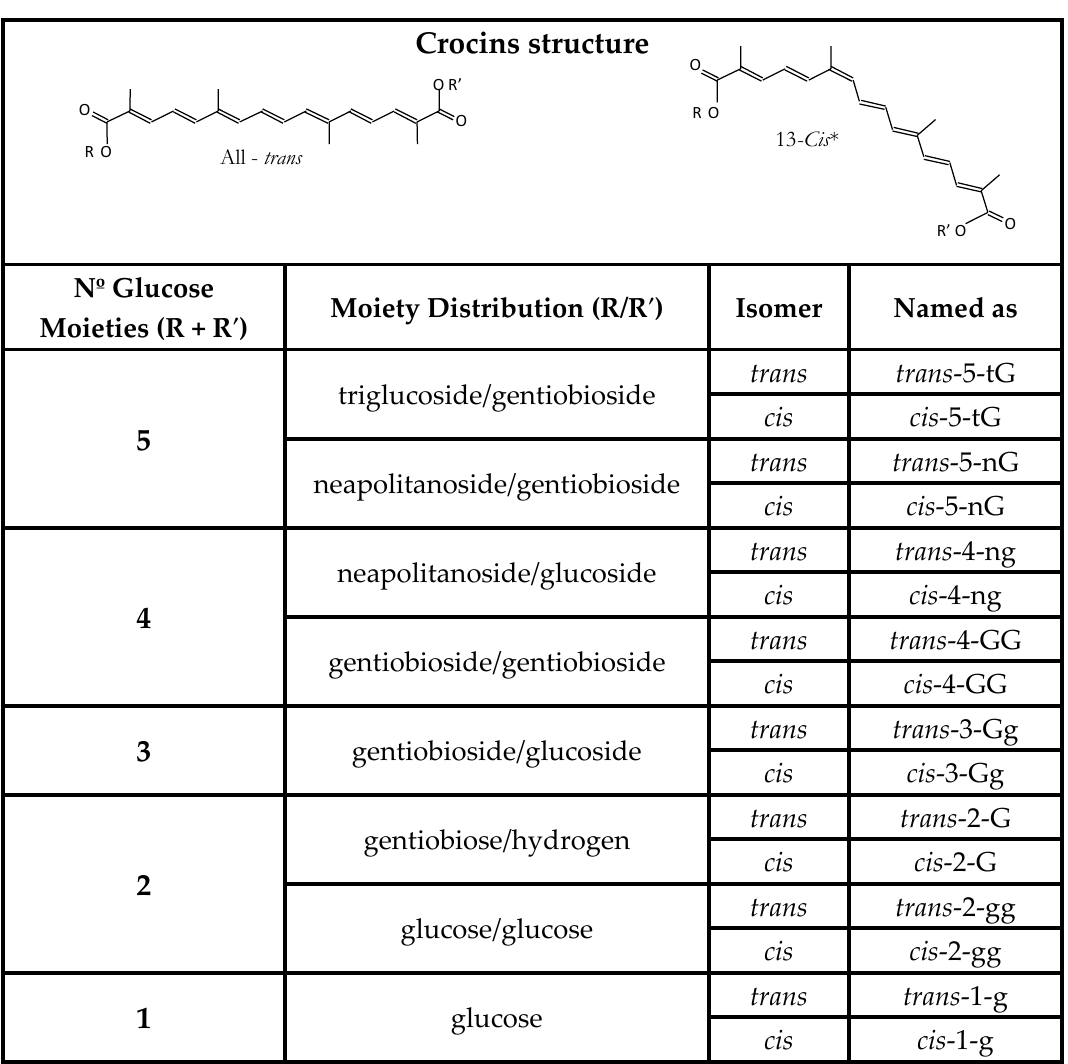
Figure 2. Simplified name of the glycosidic esters, crocins, of the carotenoid crocetin introduced by Carmona and coworkers [22]. Meaning of the abbreviations: t is triglucose; G is gentiobiose; n is neapolitanose; g is glucose.